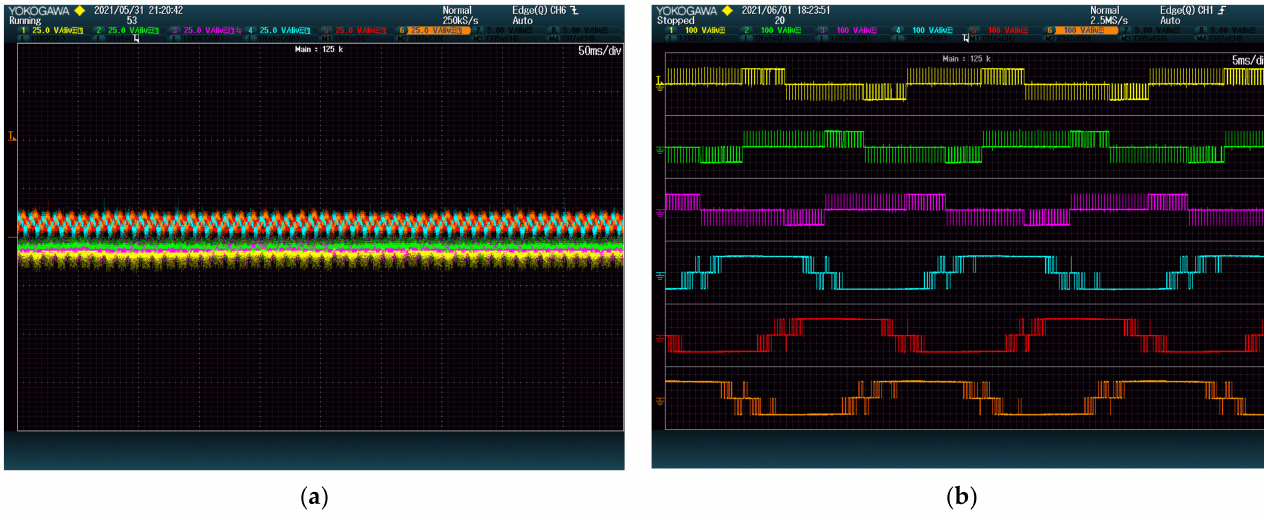
Figure 8. Fifth test results, with ripple penalization on the other half of the modules ( G Pk 1 = 0.1): ( a ) DC- link voltage ripple (25 V/dv) vs. time (50 ms/div); ( b ) Modules output voltages for 2.5 grid